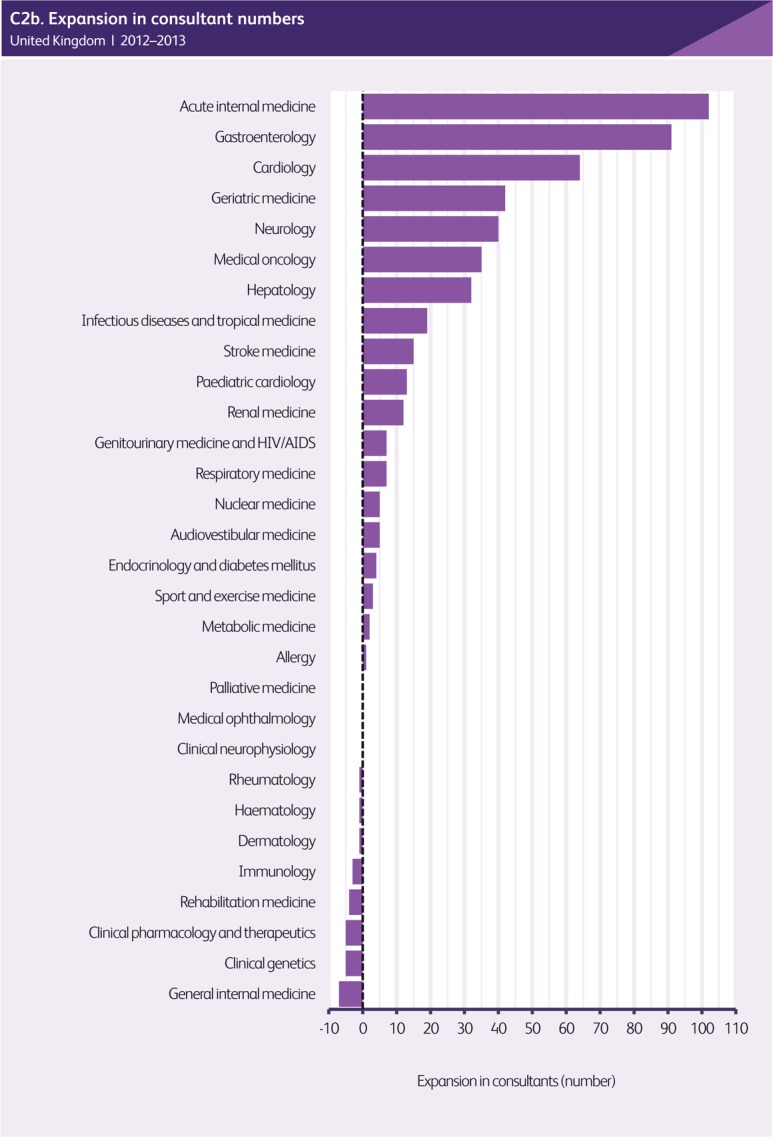
Data provided by the Royal College of Physicians shows that medical oncology is growing rapidly and is one of the fasting growing sub-specialties of Medicine. Reproduced with permission. (Federation of the Royal Colleges of Physicians of the UK. Census of consultant physicians and higher specialty trainees in the UK, 2013–14: data and commentary. London: Royal College of Physicians, 2015: 8.)